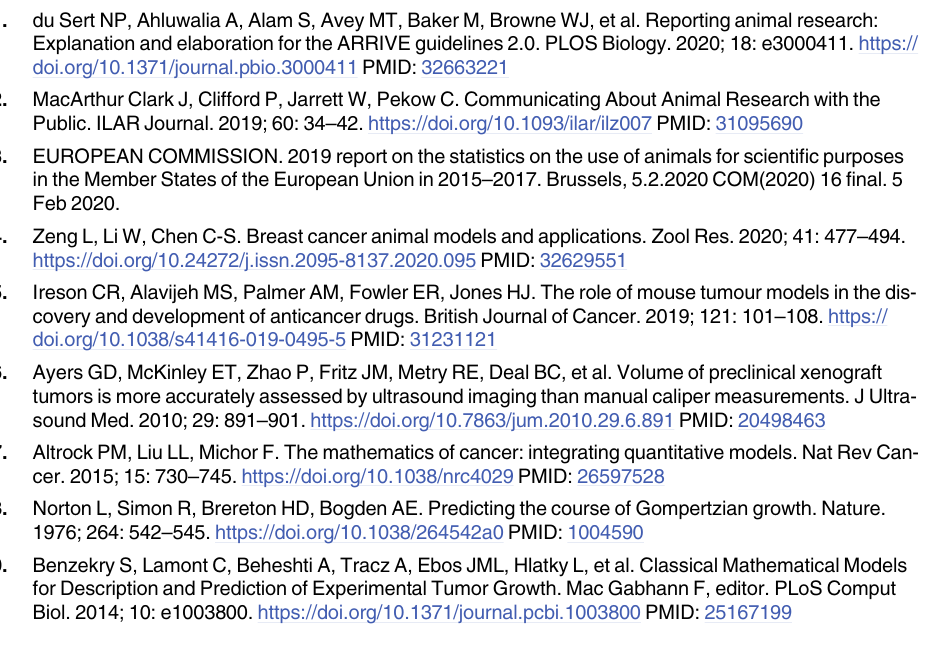
S3 Table. Parameter estimates of the Gompertz model obtained fitting the data obtained with different formulations. α _0 is the specific growth rate (in 1/days), β is the parameter driving the exponential decrease of the proliferation rate (in 1/days), and σ is the error model parameter. R.S.E. is the relative standard error on parameter estimation. CV is the coefficient of variation expressed as 100 � exp( ω ^2 − 1). S4 Table. Volume estimation data (i.e., MRE, MAE, r 2 , a and Error Model Parameter) for Formula 1 (F1), Formula 2 (F2) Formula 3 (F3), Formula 4 (F4), Formula 5 (F5), Formula 6 (F6) and Formula 7 (F7). � MRE = mean relative error, MAE = mean absolute error, r 2 = correlation coefficient of regression line, a = slope of regression